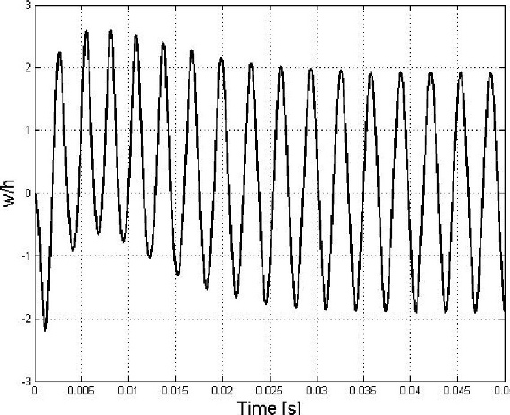
Figure 6. Nonlinear one-mode approximation for the response of a composite plate to a Friedlander